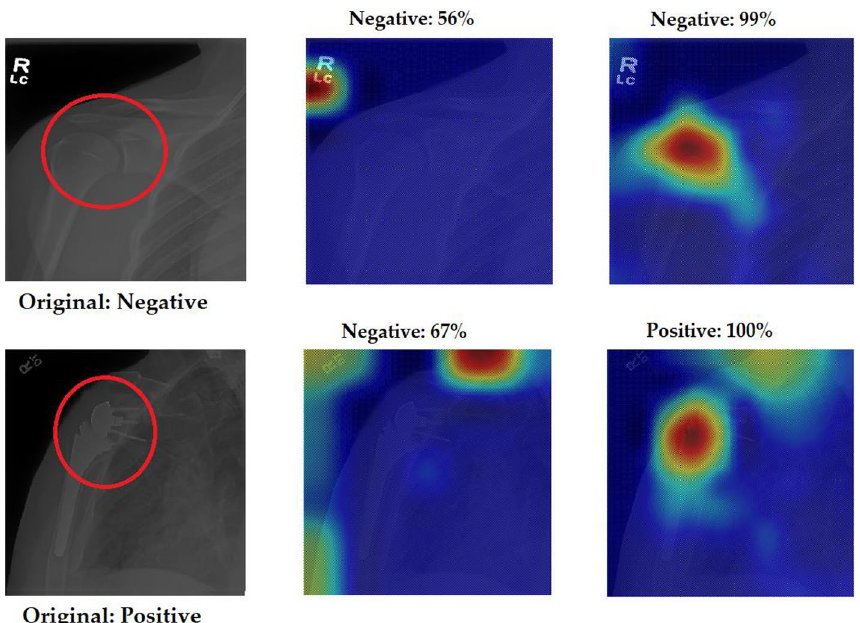
Fig. 9 Comparison between two different